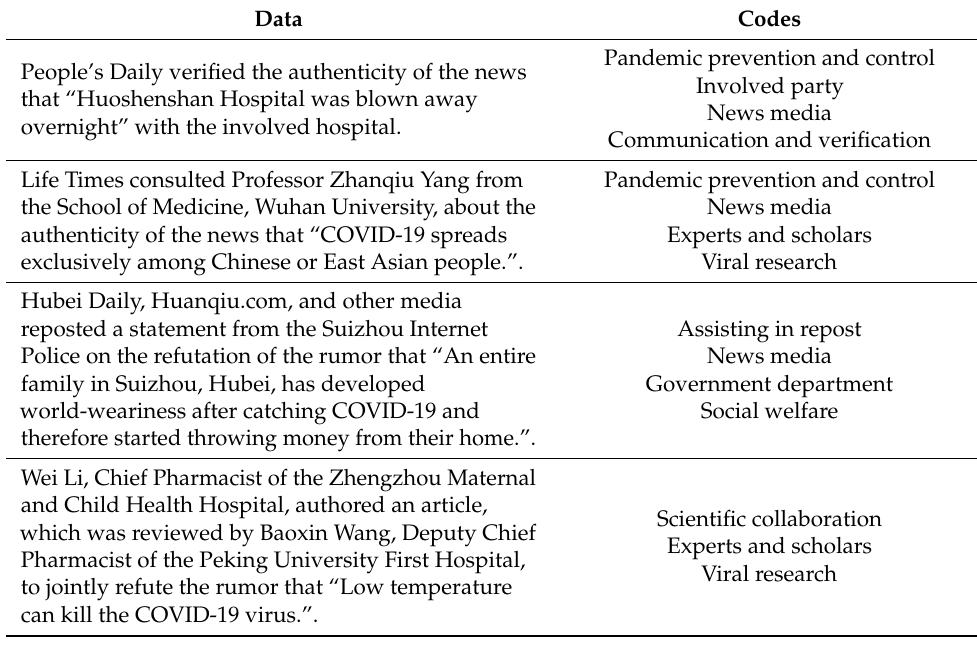
Table 1. Examples of